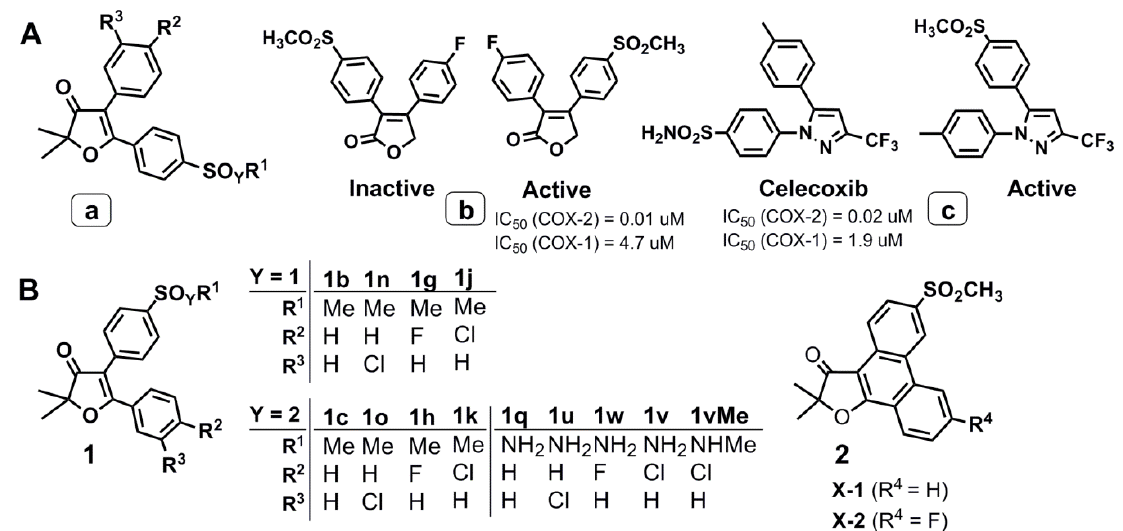
Figure 1. ( A ) Known 3( 2H ) furanones (a) [19,28], rofecoxib analogs (b), celecoxib and its regioisomer active analog (c) [29]. ( B ) Novel 3( 2H )furanone ( 1 ) and phenanthro[9,10-b]furan-3-one ( 2 )